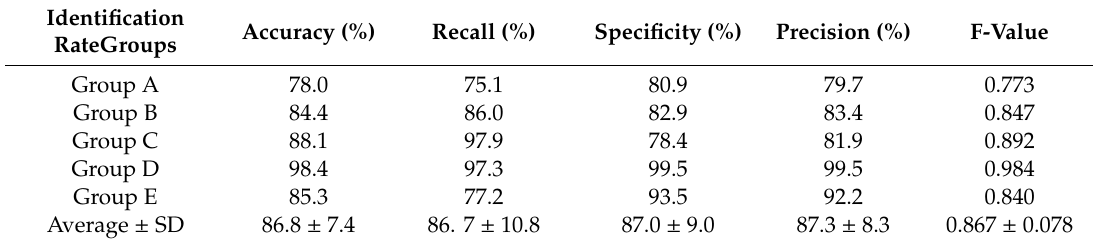
Table 4. Identification rate of the neural network based on oxy image data.